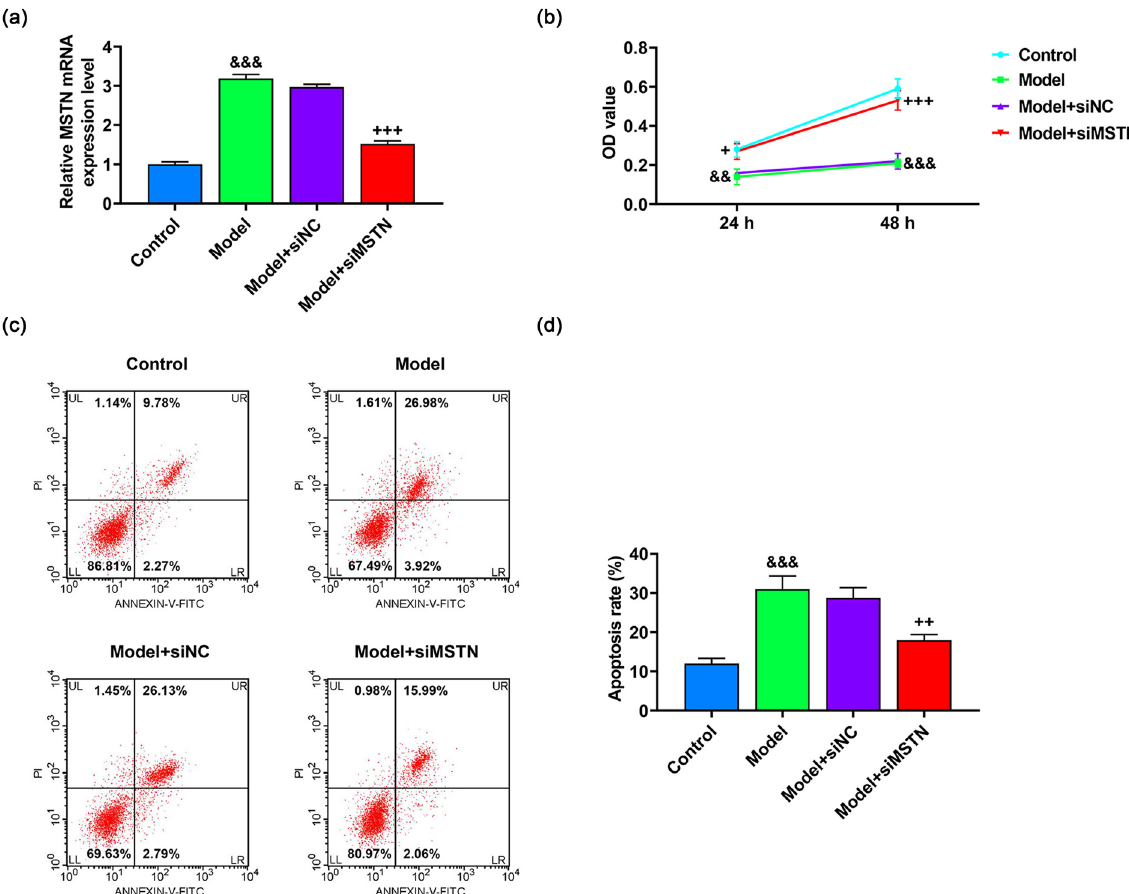
Figure 3: E ff ects of siMTSN on the viability and apoptosis of Ang II - induced AB8/13 cells. AB8/13 cells were treated with Ang II ( 100 nmol/L ) to induce MN cell model, followed by the transfection of siNC or siMSTN. ( a ) Expression of MSTN in the control, model, model + siNC, and model + siMSTN groups was quanti fi ed by qRT - PCR, with GAPDH serving as the internal reference. ( b ) OD value of AB8/13 cells at 24 and 48 h was assessed by CCK - 8 assay. ( c and d ) AB8/13 cell apoptosis was determined by fl ow cytometry. All experiments were repeated three times to obtain average values. The data are presented as the mean ± SD of three independent experiments; && p < 0.01, &&& p < 0.001 vs Control; + p < 0.05; ++ p < 0.01; +++ p < 0.001 vs Model + siNC. Abbreviation: MN, membranous nephropathy; MSTN, myostatin; Ang II, angiotensin II; qRT - PCR, quantitative real - time PCR; GAPDH, glyceraldehyde - 3 - phosphate dehydrogenase; OD, optical density; CCK - 8, cell counting kit - 8; siMSTN, small interfering RNA targeting MSTN; siNC, siRNA negative